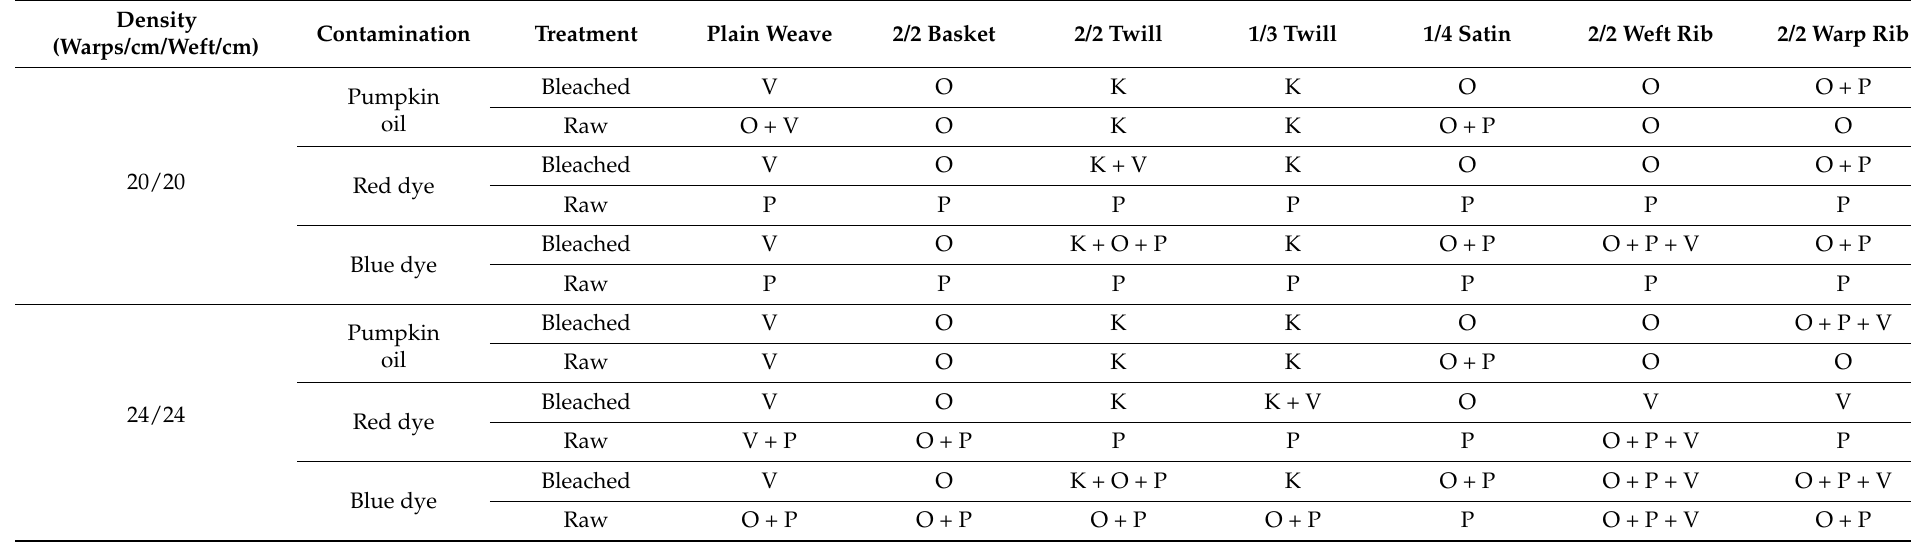
Table 3. Penetration of contamination (direction, rate, and level of absorption) depending on the fabric weave, density, and type of